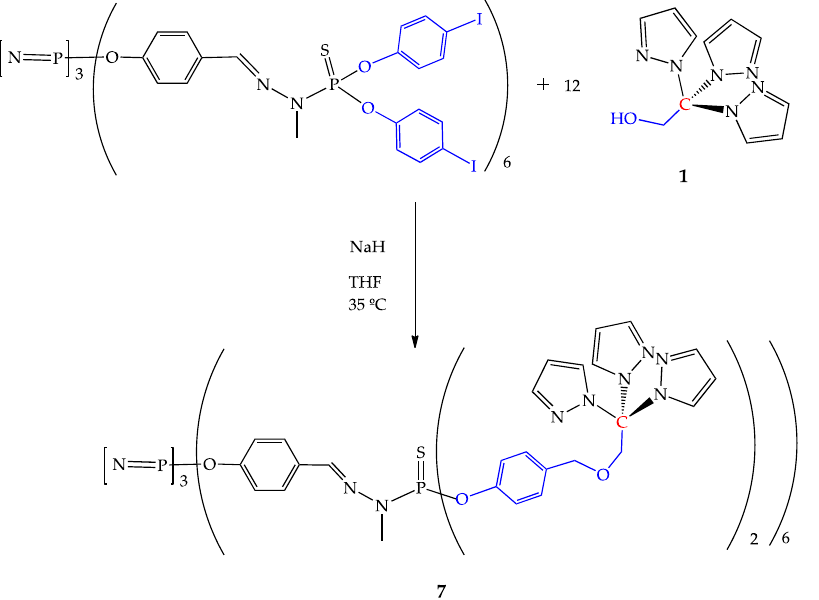
Scheme 6. Grafting reaction of tris-2,2,2-(1-pyrazolyl)ethanol ( 1 ) on the N 3 P 3 -G c1 -I 12